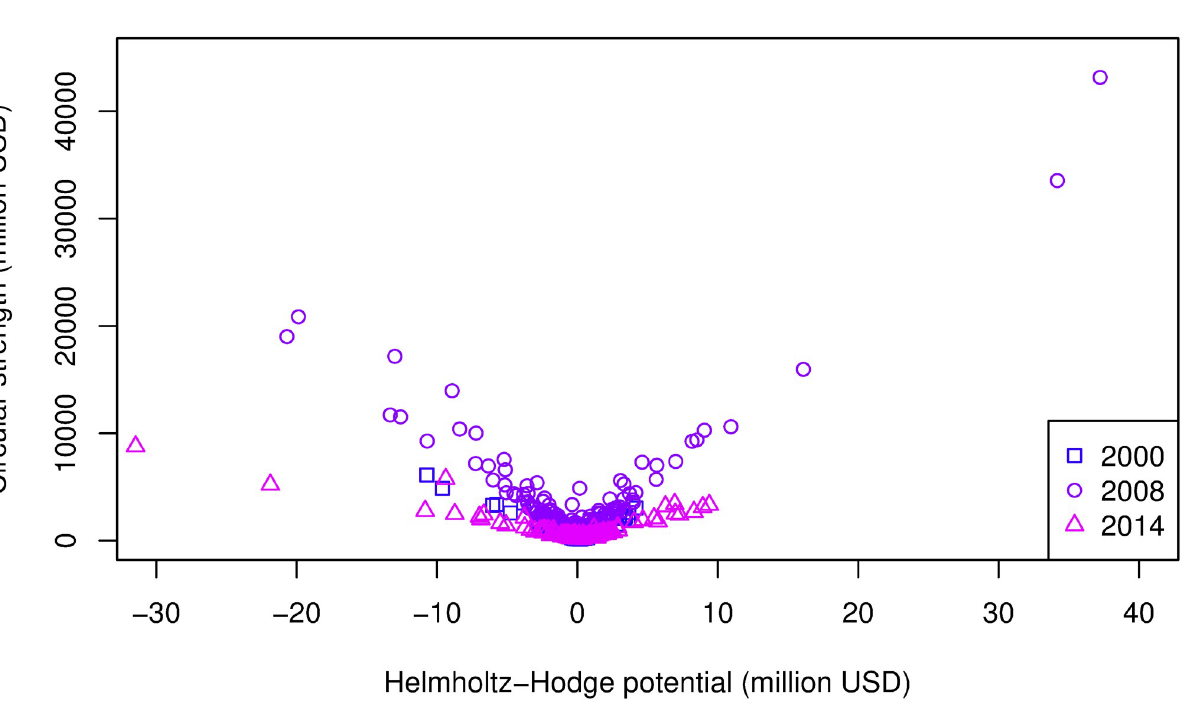
Fig 6. Scatter plot of correlation between circular strength and Helmholtz–Hodge potential in European community in 2000, 2008, and 2014. Each year shows a V-shaped pattern, but the inclination is changed (sharpest in 2008 and gentlest in 2014).